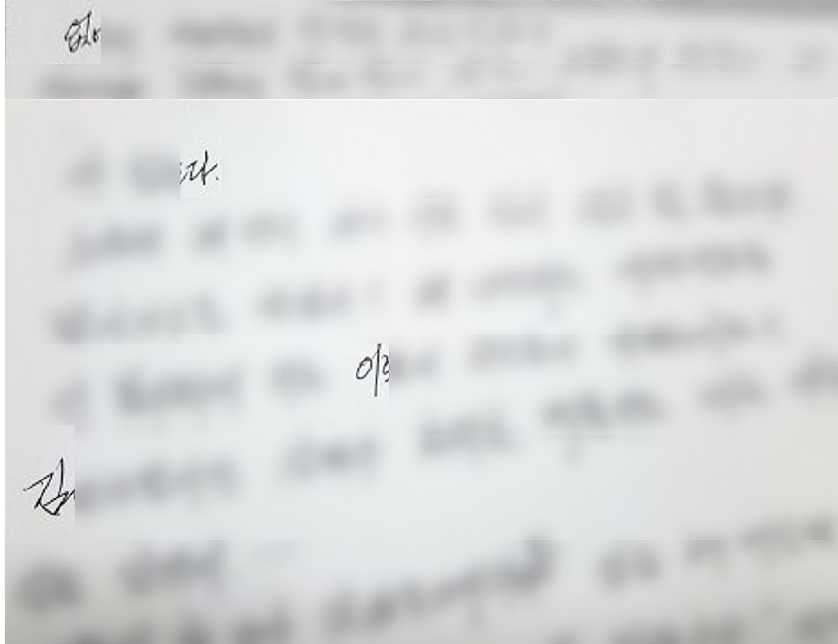
Figure 1. Example of a will containing four characters.